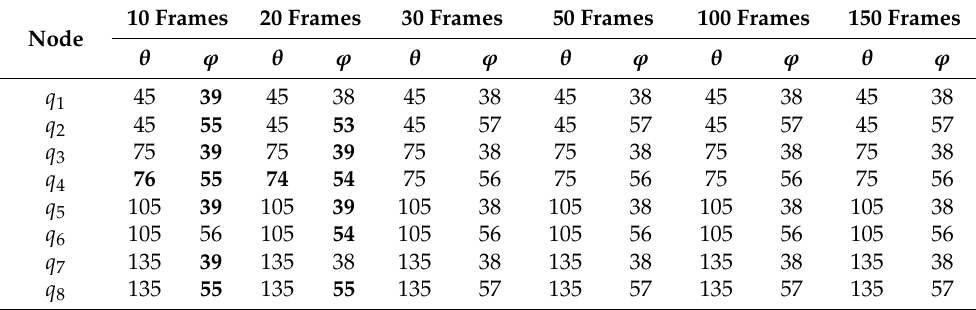
Table 3. Identified sound source (cluster center) coordinates with different number of frames.